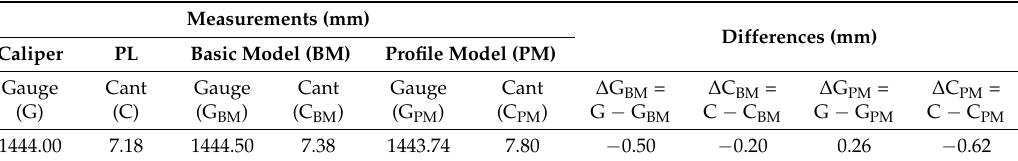
Table 3. Track gauge (G) and cant (C) measurements results on the 3D rail track models.